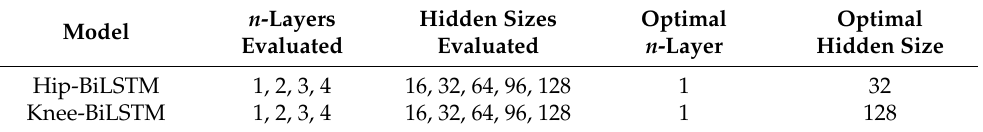
Table 1. Architecture of bidirectional long short-term memory neural networks withtuned hyperparameters. Model